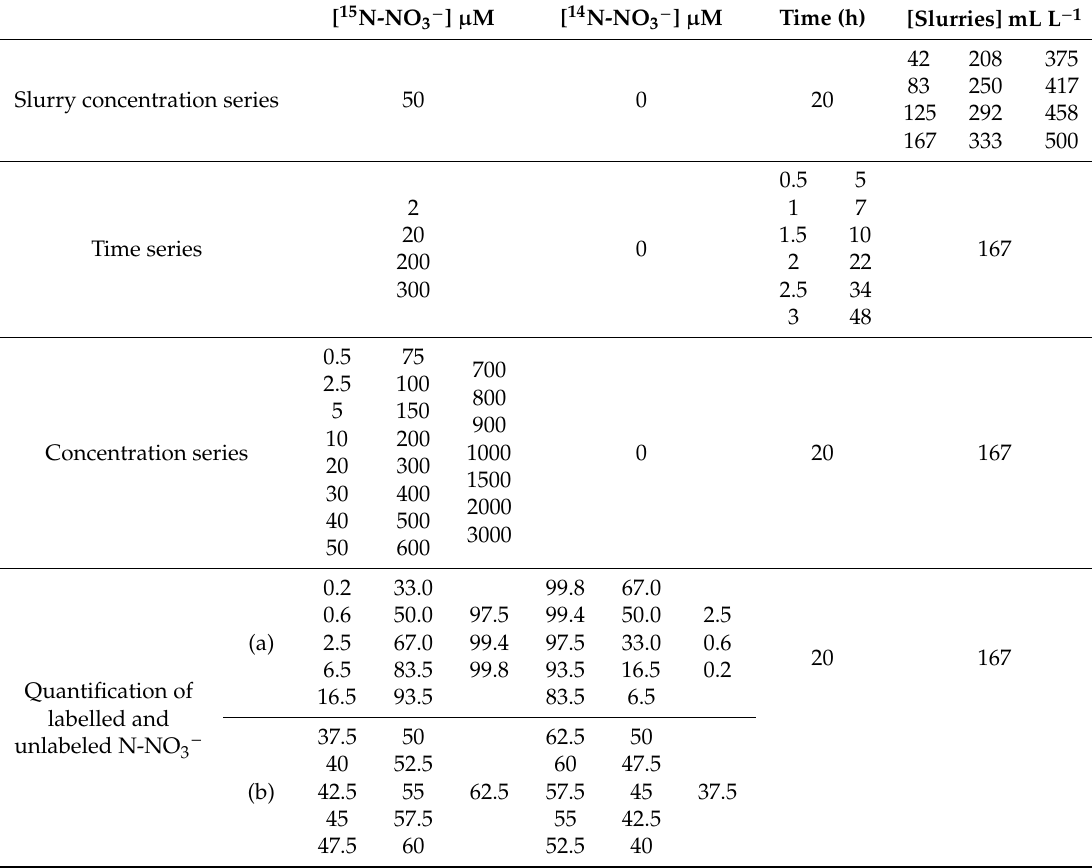
Table 1. Summary of the experimental conditions of each test. Every tested condition was run in triplicate.